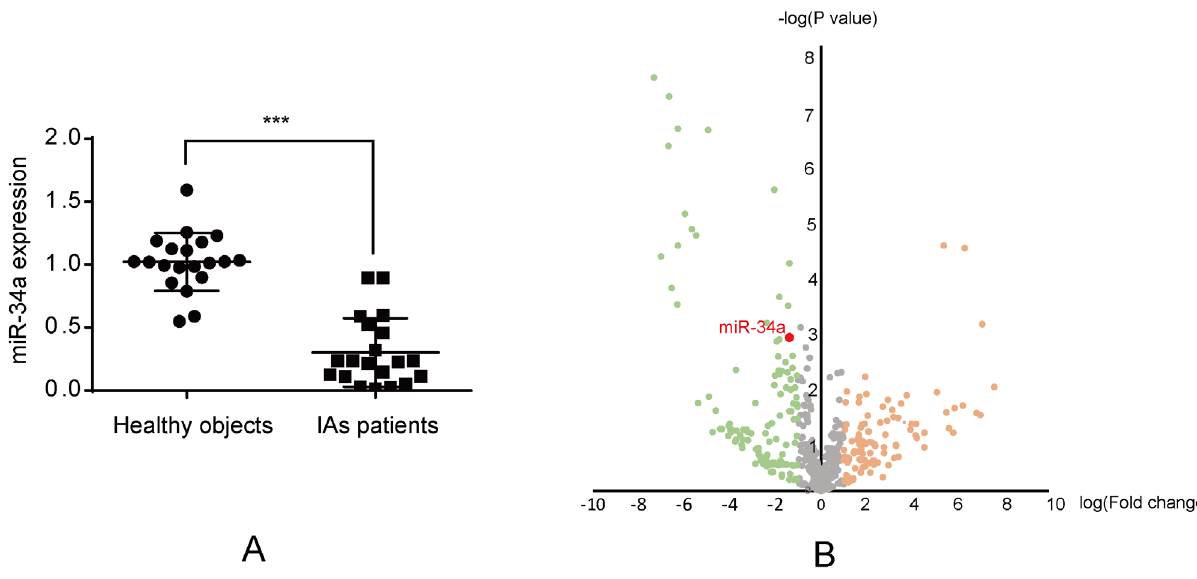
Figure 1 – miR-34a expression. (A) Real-time PCR test for miR-34a in IA patients and healthy group, ***p < 0.0001. (B) GEO data (GSE46336) was downloaded from GEO datasets in NCBI and analyzed, in which, x axis represents log (fold change) and y axis represents log (-P